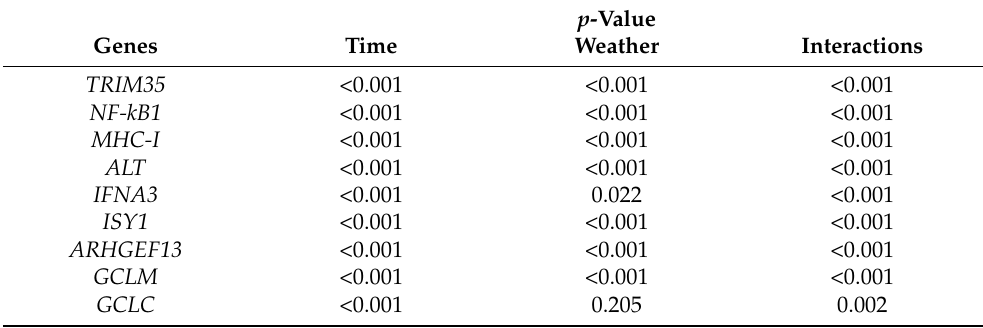
Table 8. Effects of light intensity and duration on immune genes in mackerel tuna under different weather